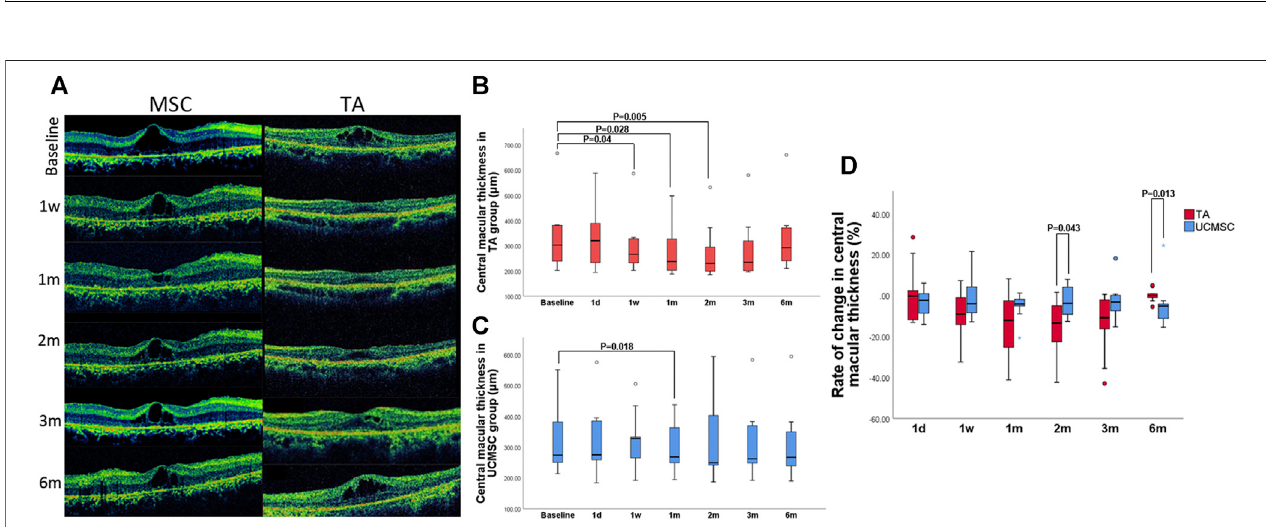
FIGURE 3 | Assessment of central macular thickness. (A) Morphological changes in the UCMSCs infusion and TA injection groups (B) In the TA group, the CMT signi fi cantly decreased at fi rst week, fi rst and second month ( p (cid:2) 0.04,0.028,0.005 respectively, n (cid:2) 20, Wilcoxon signed-rank test). At 3rd and sixth month, the CMT graduallyincreasedtobaselinelevel( p > 0.05, n (cid:2) 20,Wilcoxonsigned-ranktest). (C) IntheUCMSCsgroup,theCMTat fi rstmonthwassigni fi cantlylowerthanbaseline ( p (cid:2) 0.018, n (cid:2) 20,Wilcoxonsigned-ranktest).TheCMTatthirdandsixthmonthwerealsolowerthanbaseline,buttherewasnosigni fi cantdifference( p > 0.05, n (cid:2) 20, Wilcoxon signed-rank test). (D) Comparison of the rate of change in CMT between two groups: At 2nd month, the rate of reduction of CMT in TA group was signi fi cantlygreaterthanthatinUCMSCsgroup( p (cid:2) 0.043, n (cid:2) 20,Mann – WhitneyUtest).At6thmonth,therateofreductionofCMTinUCMSCsgroupwassigni fi cantly greater than that in TA group ( p (cid:2) 0.013, n (cid:2) 20, Mann – Whitney U test).